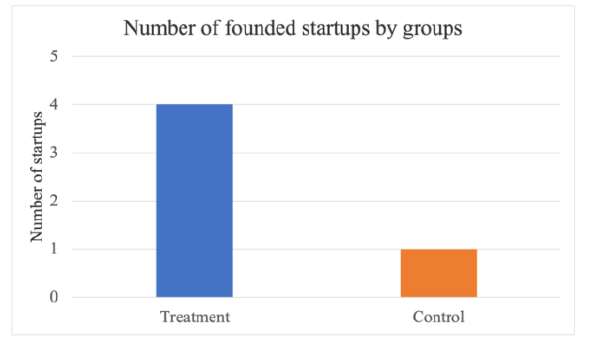
Fig. 2. H-index distributions for the two groups.